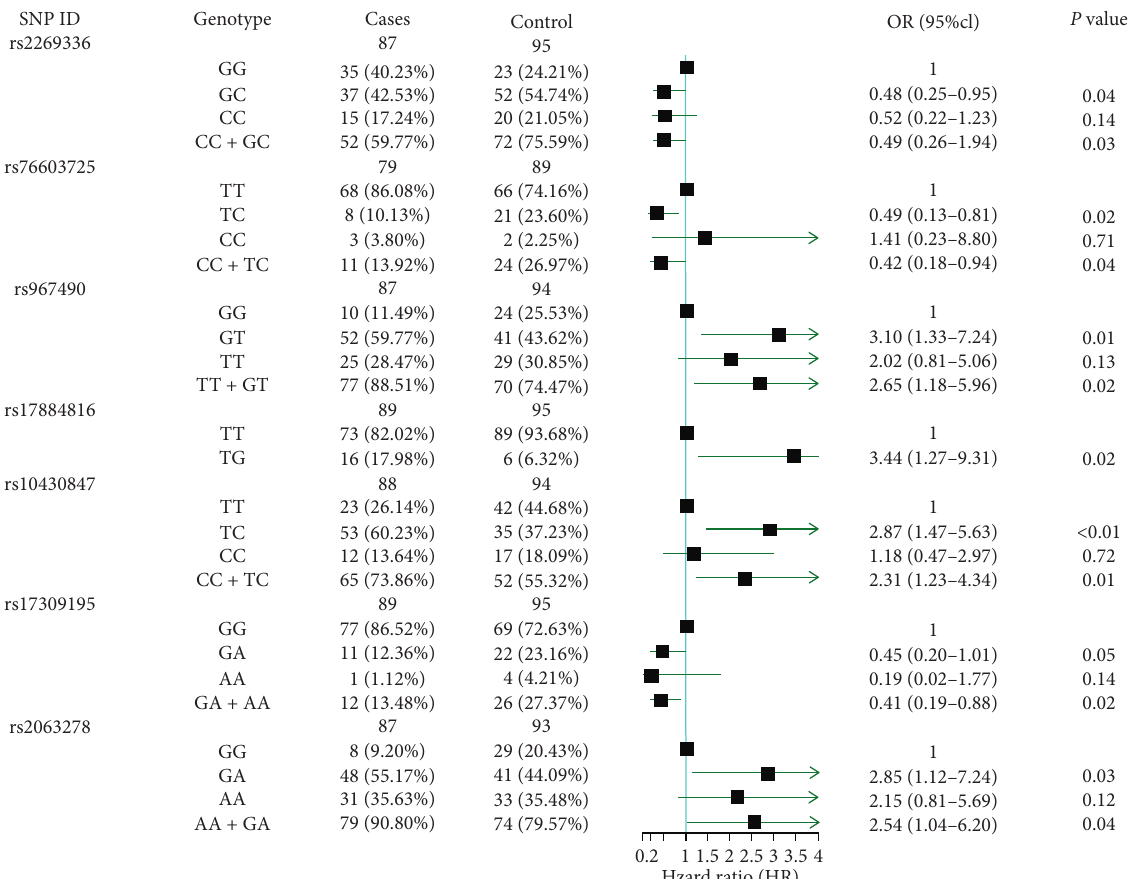
Figure 1: Logistic regression analysis of associations between the genotypes of selected SNPs and capsules